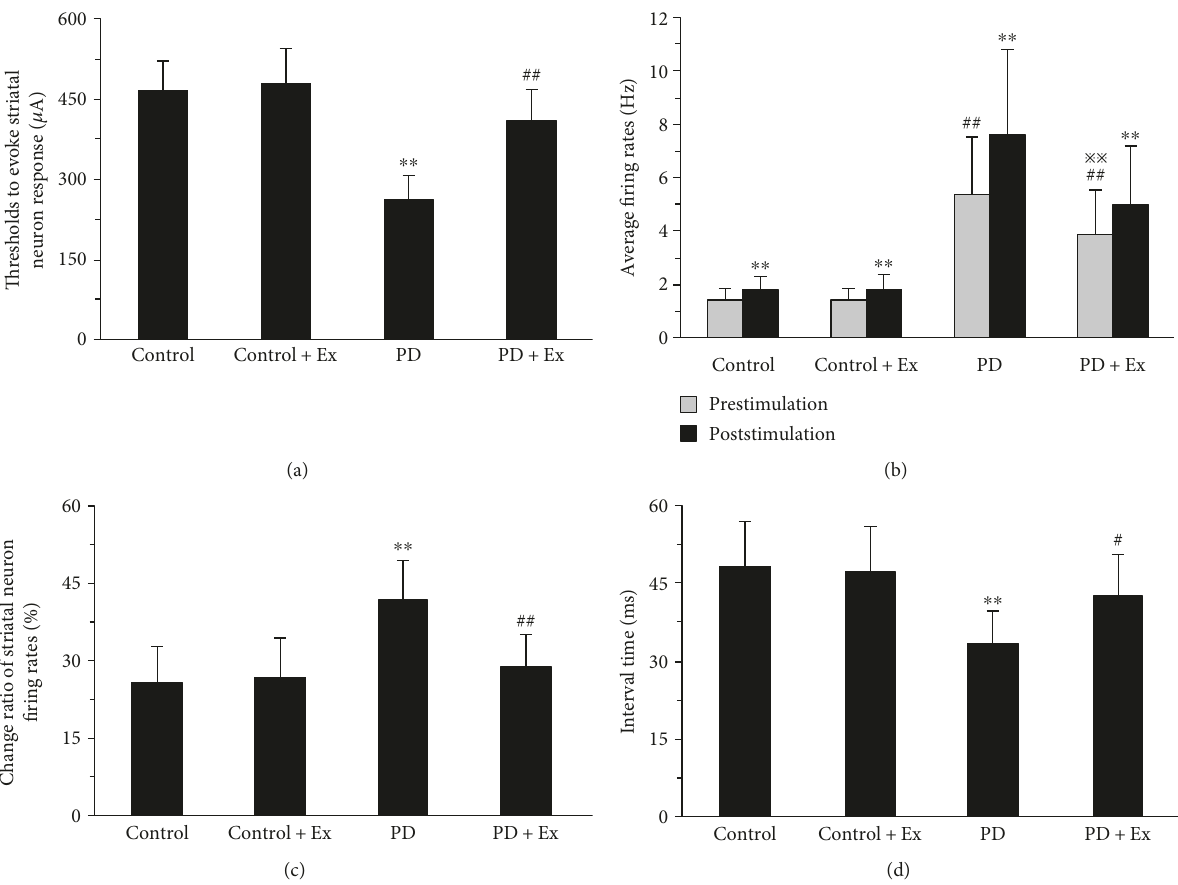
Figure 8: E ff ect of treadmill exercise on evoked electrical activity of striatal neurons in the rat model of Parkinson ’ s disease. (a) The thresholds for evoking striatal neuron responses in rats. (b) Changes in average fi ring rates in striatal neurons after cortical stimulation. Analysis of spontaneous fi ring patterns in striatal neurons. (c) Change ratio of striatal neuron fi ring rates after stimulation. (d) The interval time of striatal neurons response after cortical stimulation. (a, c, d) Compared to the control groups, ∗∗ P < 0 01 . Compared to the PD groups, # P < 0 05 and ## P < 0 01 . (b) Compared to before cortical stimulation, ∗∗ P < 0 01 . Compare to the control groups, ## P < 0 01 . Compared to the PD groups, ※※ P < 0 05 . Control: control group; control +Ex: control plus exercise group; PD: Parkinson ’ s disease group; PD+ Ex: Parkinson ’ s disease plus exercise